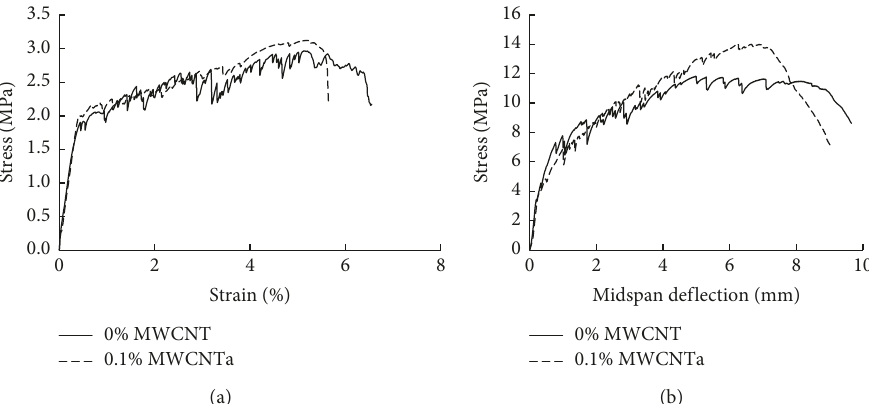
Figure 4: Typical mechanical behavior of different ECC mixes. (a) Uniaxial tensile stress-strain curve. (b) Midspan deflection under flexural loading.